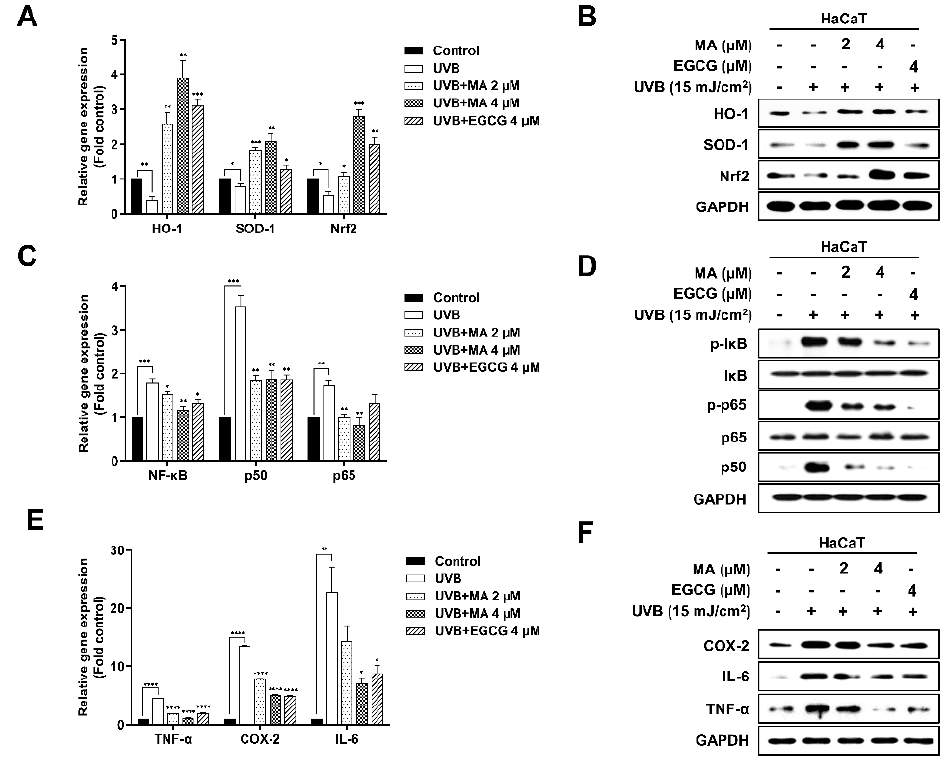
Figure 3. Effect of malonic acid (MA) on antioxidant enzymes, nuclear factor (NF)- κ B activation, and inflammatory mediators in ultraviolet (UV) B-irradiated HaCaT cells. (A-F) HaCaT cells have been treated with MA for 4 h and then exposed to UVB irradiation (15 mJ/cm2). After an overnight incubation following UV exposure, the antioxidant enzymes (heme oxygenase 1 (HO-1), superoxide dismutase 1 (SOD-1), and nuclear factor-erythroid 2-related factor-2 (Nrf2)) are evaluated by ( A ) real-time polymerase chain reaction (PCR) and ( B ) western blot analysis. NF- κ B, p50, and p65 are evaluated by ( C ) real-time PCR and ( D ) western blot analysis. The inflammatory mediators (tumor necrosis factor (TNF)- α , cyclooxygenase-2 (COX-2), and interleukin-6 (IL-6)) are evaluated by ( E ) real-time PCR and ( F ) western blot analysis. +, - means UVB irradiation or non-irradiation and treatment or non-treatment of MA and EGCG. Glyceraldehyde 3-phosphate dehydrogenase (GAPDH) is used as an internal control for western blot analysis. Epigallocatechin-3-gallate (EGCG) is used as a positive control. The data were analyzed in triplicate and displayed as the mean ± the standard error of the mean (SEM). (*) p < 0.05, (**) p < 0.01, (***) p < 0.001, and (****) p < 0.0001.